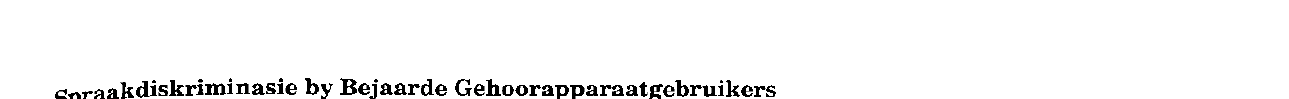
Tabel 2 verskaf 'n oorsig van en motivering vir die verskillende toetse en materiaal wat tydens die